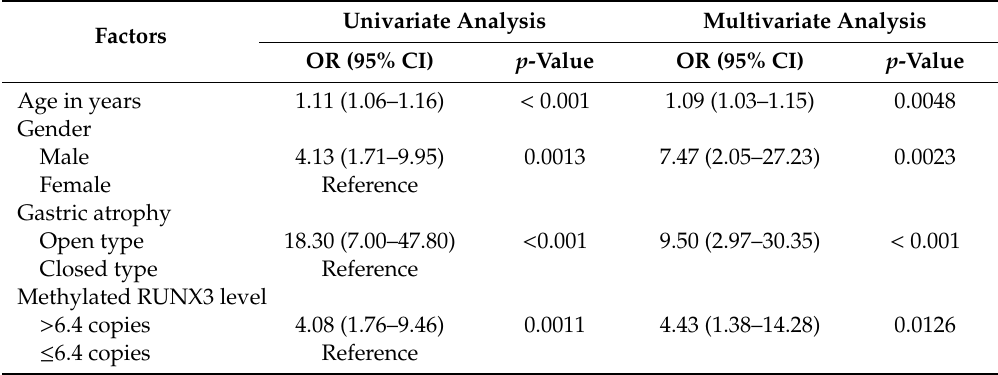
Figure 3. Comparison of tumor characteristics and clinical course with methylated RUNX3 copy numbers. ( a ) The correlation between tumor size and the copy numbers of methylated RUNX3 is shown. In all panels, the numbers of methylated RUNX3 copies per a DNA amount equivalent to that in 40 µ L of serum are shown, with open circles indicating the individual samples. ( b – f ): the distribution of copy numbers of methylated RUNX3 according to the depth of tumor invasion ( b ), the presence of lymph-vascular invasion ( c ), the titer of H. pylori antibody ( d ), the presence of H. pylori eradication ( e ), and the severity of endoscopic gastric atrophy ( f ). In panels ( b – f ), box plots show the median and interquartile range (25th and 75th percentiles). Table 2. Risk factors for gastric cancer.